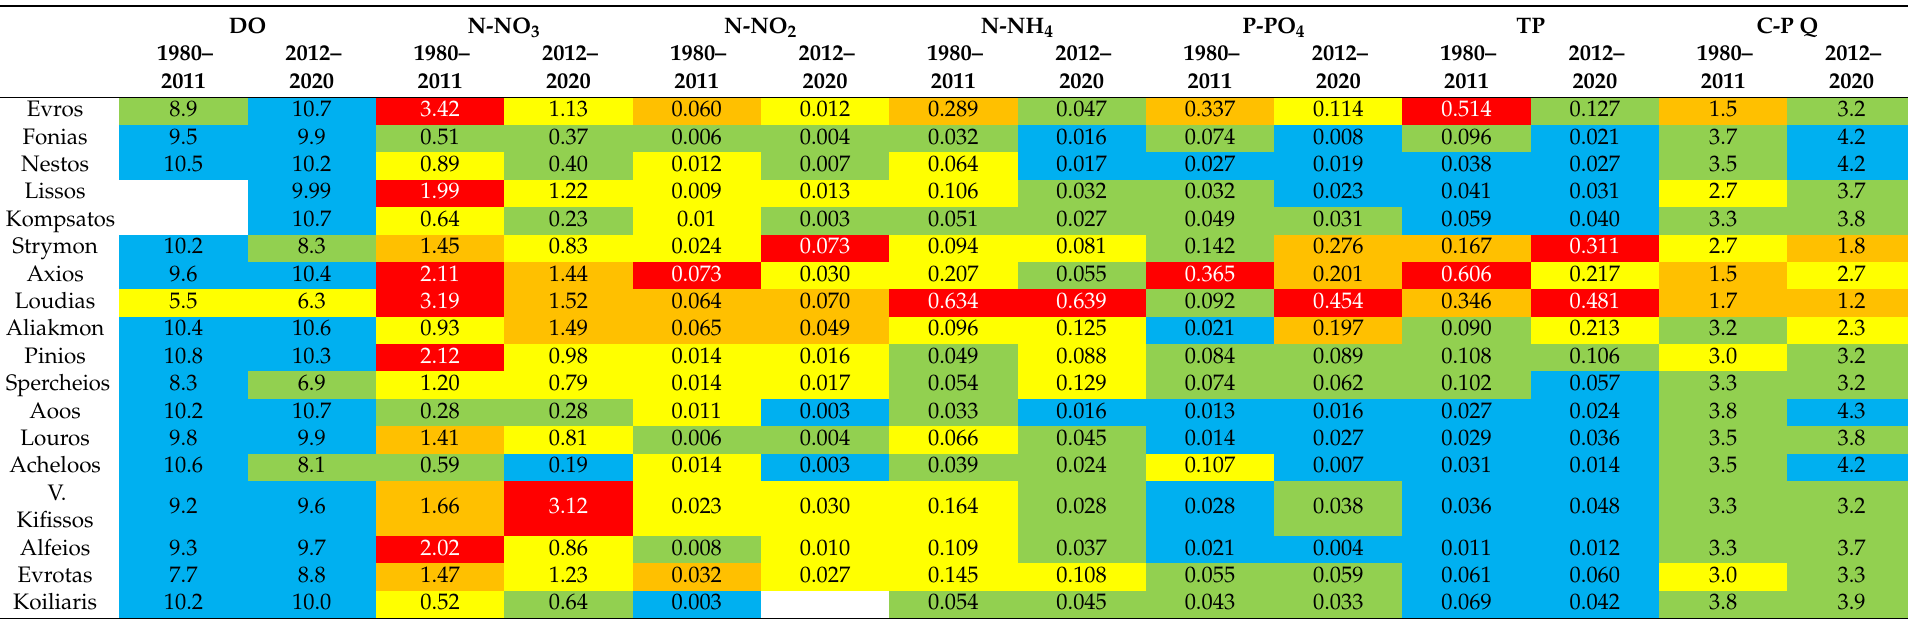
Table 4. Concentrations and quality classification [37] of riverine nutrients and DO (in mg/L) near the river outflows for the periods 1980–2011 and 2012–2019. Colors present quality classes. Numbers within chemical-physicochemical (C-P) quality present the scores of quality classes. H: high, G: good, M: moderate, P: poor, B: bad. Colors of quality status correspond to the WFD